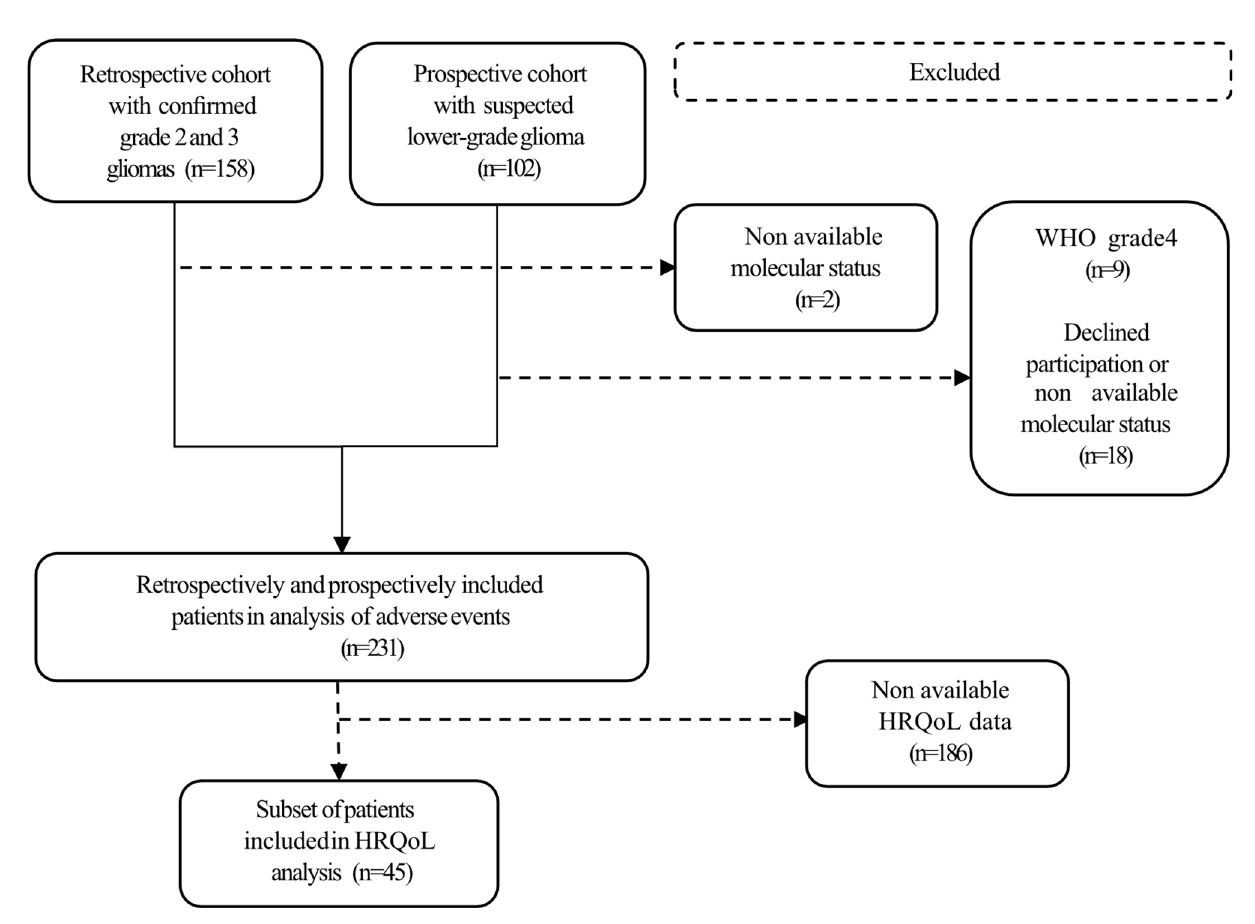
FIGURE 1 | Flow chart of included